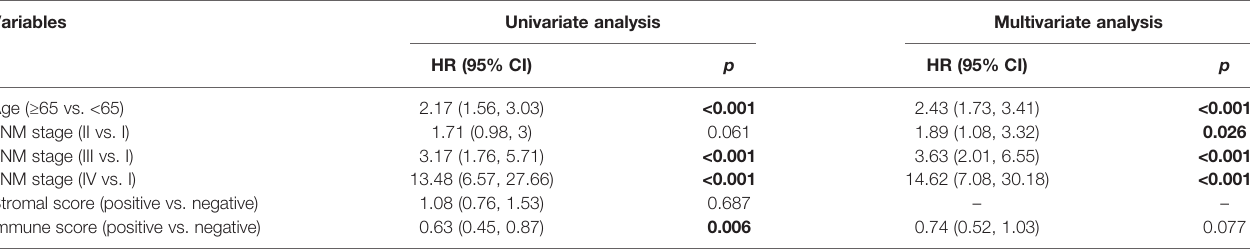
TABLE 1 | Cox proportional hazards regression model analysis of overall survival based on TCGA-BRCA database. Variables